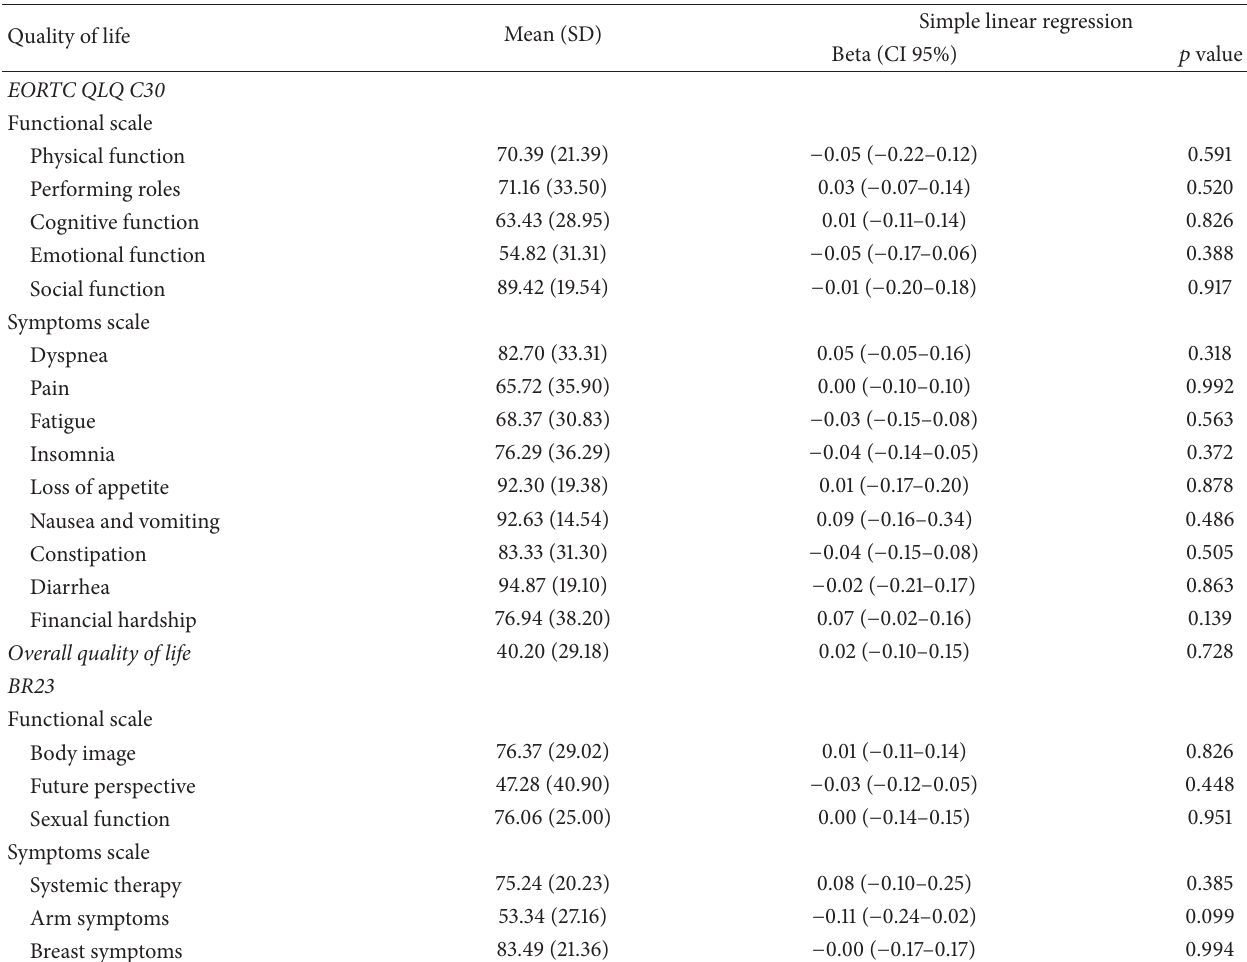
Table 3: Linear regression model between the score of quality of life at baseline and percentage reduction of excess volume between the upper limb after